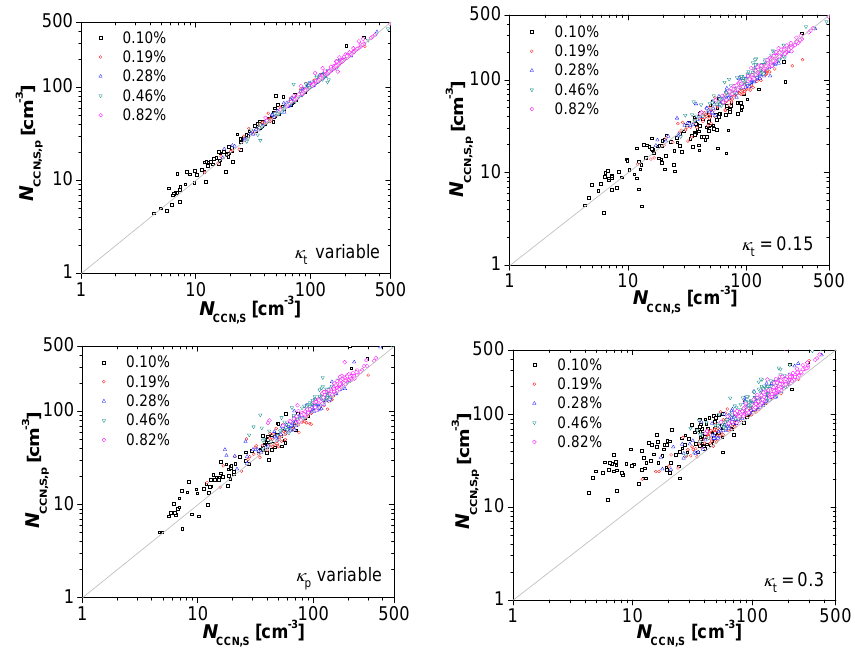
Fig. 10. Predicted vs. measured CCN number concentrations ( N CCN ,S,p vs. N CCN ,S ). Predictions are based on the κ -K¨ohler model approach using different types of effective hygroscopicity parameters: (a) variable values of κ t as derived from the individual CCN efficiency spectra; (b) constant campaign median value κ =0.15; (c) variable values of κ p predicted with organic and inorganic mass fractions determined by AMS; and (d) constant approximate global average value of κ =0.3.